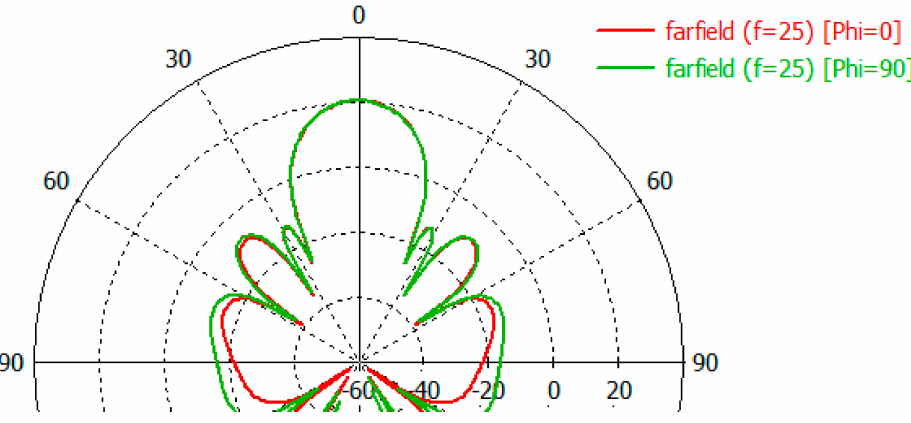
Figure 8. The E and H plane radiation pattern of 24 elements array.